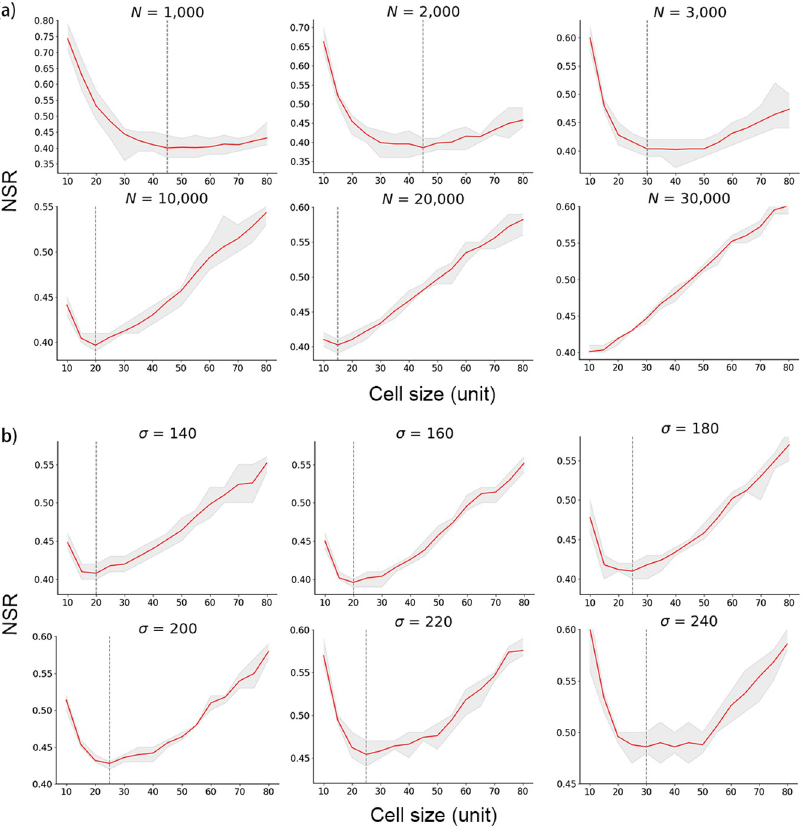
Fig 4. Correlation between the NSR and the cell size. (a) σ = 150 and N varies; (b) N = 10,000 and σ varies. The gray area represents the range of multiple experimental results and red lines mark the average value. The dotted lines mark the first local minimum